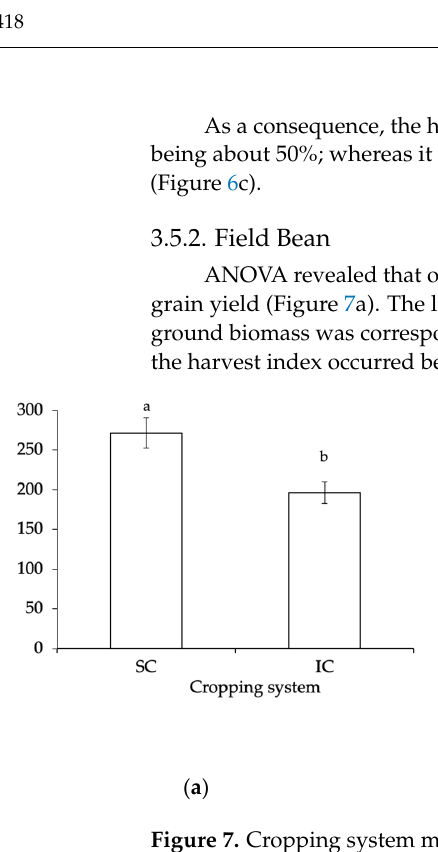
Figure 7. Cropping system main effect on ( a ) grain yield and ( b ) aboveground biomass of field bean. Values are means of two years, two harvesting stages, five N rates, and three replicates. Vertical lines represent HSD and values with the same letter are not statistically different for p ≤ 0.05. SC = sole crop; IC = intercrop.